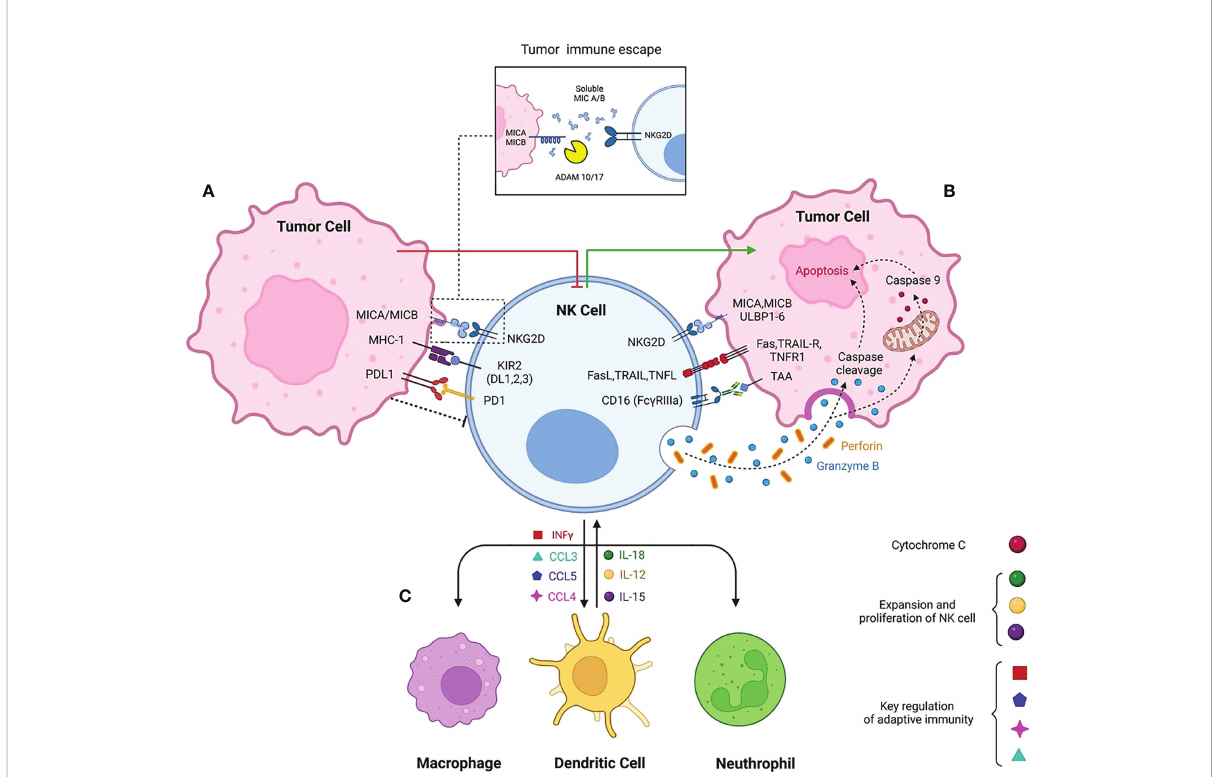
FIGURE 1 schematic diagram of Natural killer cell contribution to innate immunity. The balance of NK cells activatory and inhibitory receptors promotes either secreting cytotoxic molecules or making NK cells exhausted in TME respectively. (A) Immune suppressive TME is due to interaction of MHC-1 with inhibitory receptors such as KIR2. High expression of PDL-1 in tumor cells interacts with inhibitory checkpoint PD-1, inhibiting the NK cell activation. Beside the activatory role of MICA/MICB, the shedding form caused by ADAM17/10 cleavage makes the NK cells non responsive to tumor target cells. (B) NKG2D the most prominent activatory receptor of NK cells interact with MICA/MICB/ULBP. Following NK cells activation Fas ligand, TRAIL and TNF ligand highly express on NK cells to induce the apoptosis independent of perforin and granzyme. Antibody dependent cytotoxicity of NK cells promotes perforin and granzyme activation and consequently granzymes triggers apoptosis even dependent or independent of caspase cleavage. (C) Interaction of NK with other immune cells. NK cells secret INF g , CCL3, CCL5, CCL4 to contribute with macrophages, dendritic cells and neutrophils. The innate immune cells subsequently secret IL-15, IL-18 and IL-12 to provoke NK cells expansion and